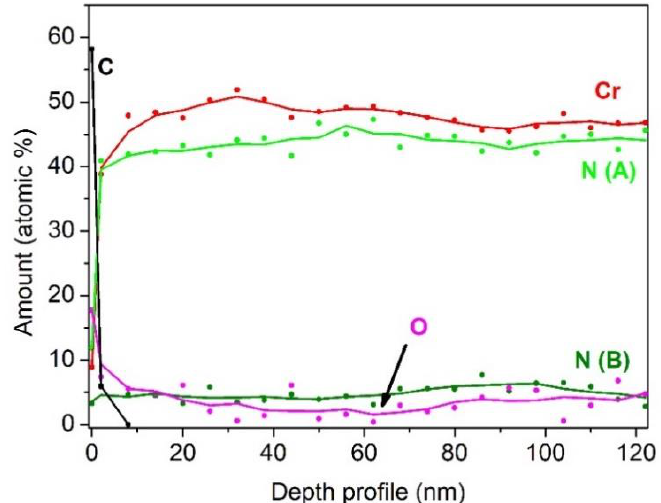
Figure 9. Peak fitting of Cr 2p spectrum acquired on the top of the multilayer coating [23]. Coatings 2020 , 10 , 1182